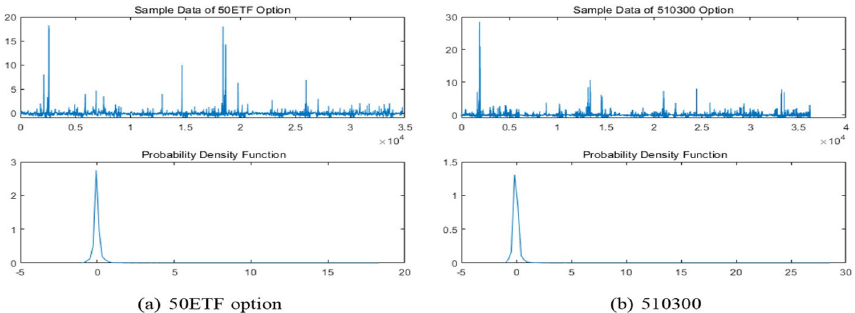
Table 2 Return characteristics of option with one-month hold to maturity